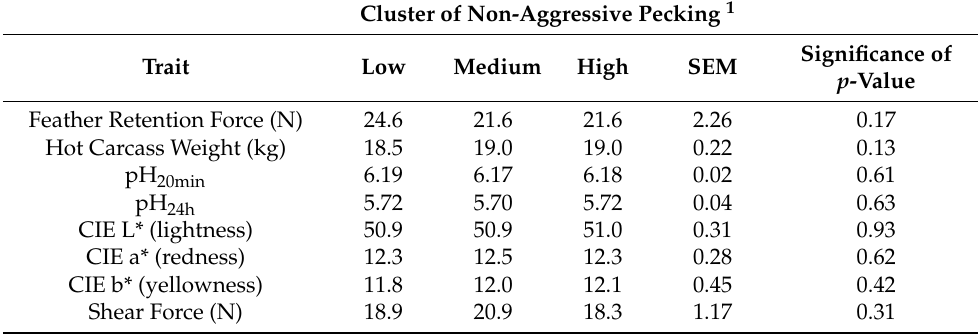
Table 10. Meat quality measurements of turkeys divided into clusters based on non-aggressive pecking